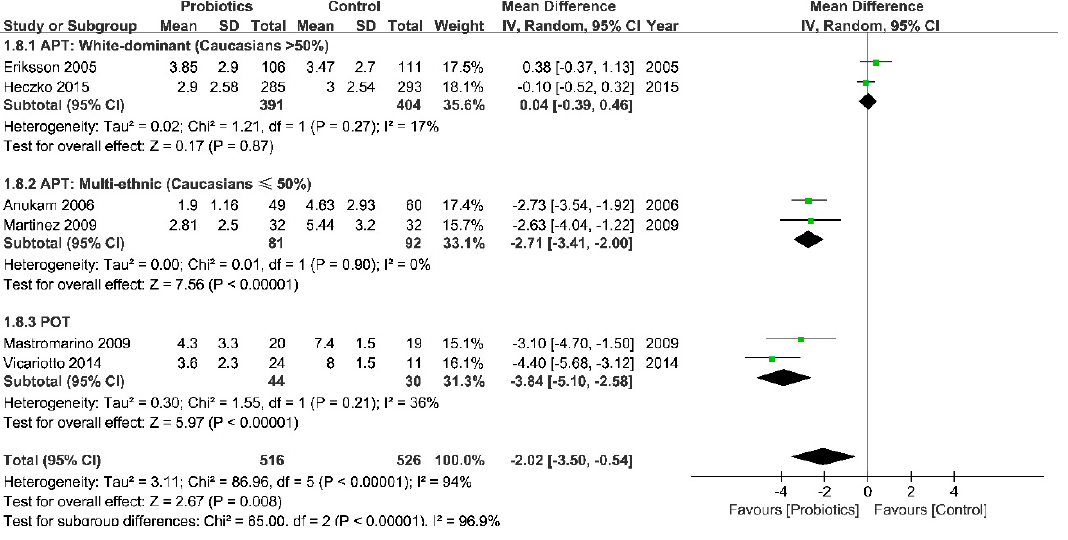
Figure 3. Forest plot: Nugent scores of probiotics vs. placebo for BV after a normal menstrual cycle (around the 30th day after intervention, divided by ethnic groups). Abbreviations: APT = antibiotic + probiotic treatment; POT = probiotic only treatment; NA = no data available.